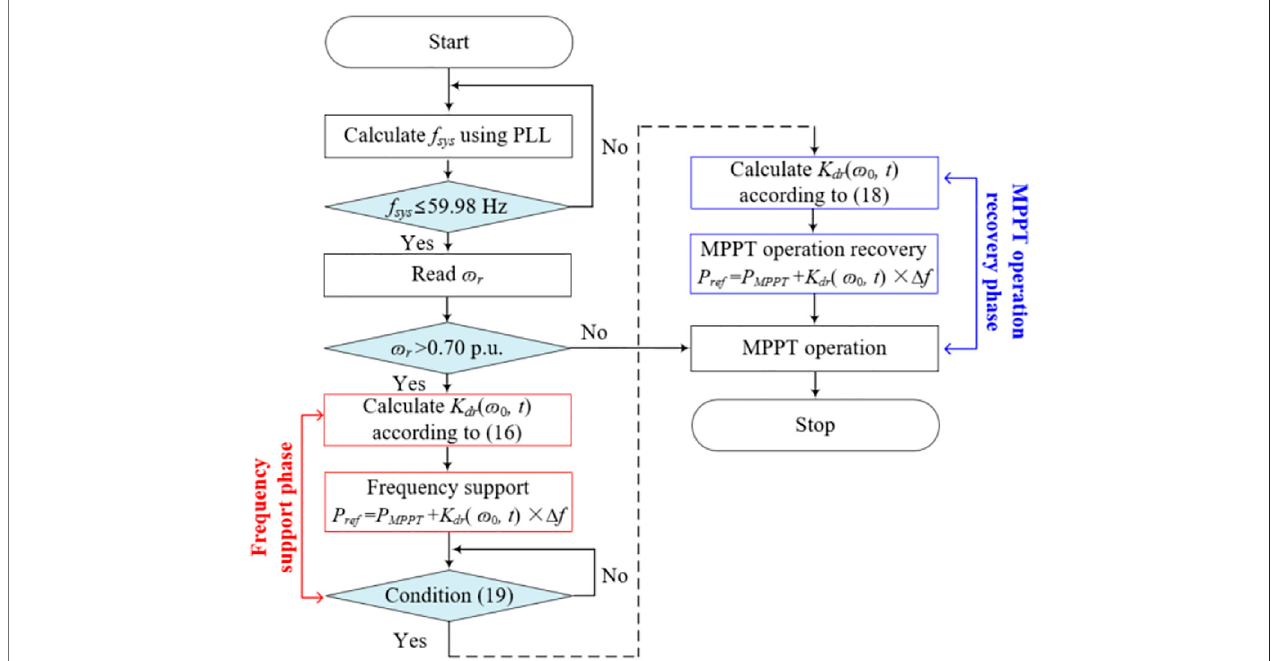
FIGURE 6 | Flowchart of the proposed two-phase short-term frequency